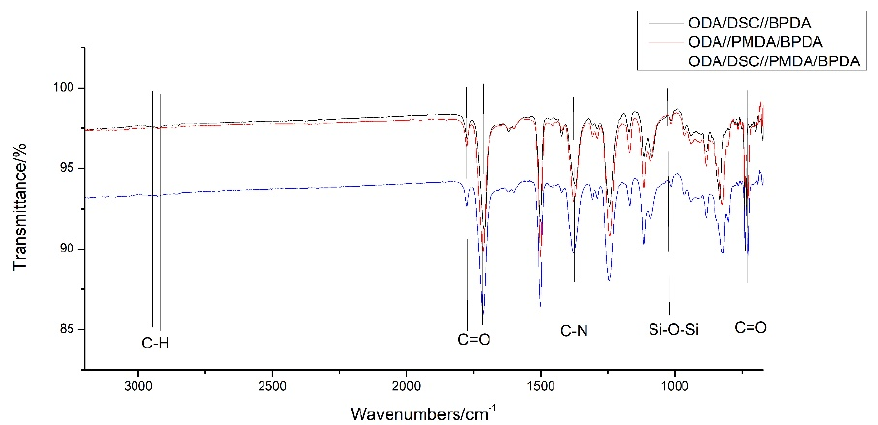
Figure 4. Infrared spectrograms of PI films in groups 2 and 3.